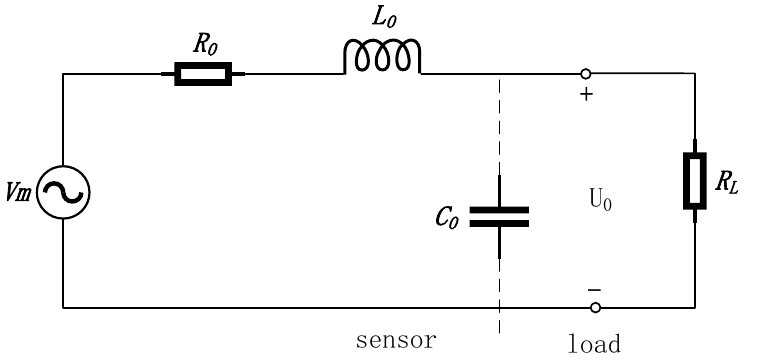
Figure 6. Thevenin’s equivalent circuit of magnetic field probe.